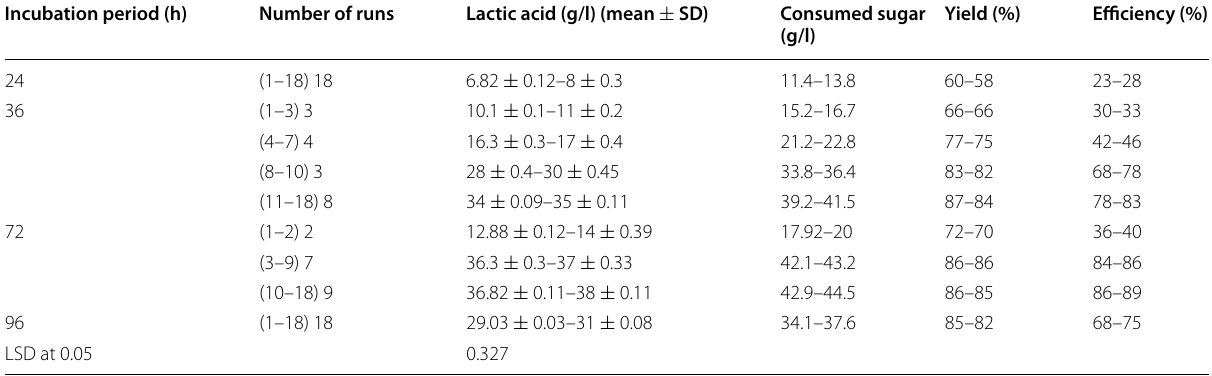
Table 8 Effect of incubation period on lactic acid production using immobilized cells of Lacticaseibacillus casei